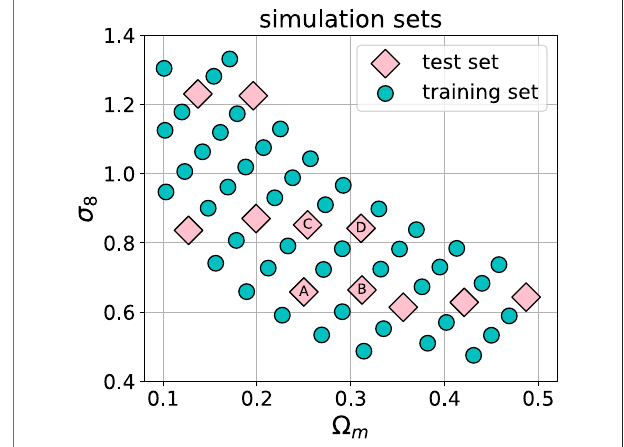
FIGURE 2 | The cosmological parameter grid used in this work, from (Fluri et al., 2019). The circles and diamonds show the training and the test sets, respectively. The total number ofmodels was57, ofwhich 46wereused asthetrainingsetand11asthetestset.ThemodelslabeledA,B,C,and D are investigated in more detail in Section 5